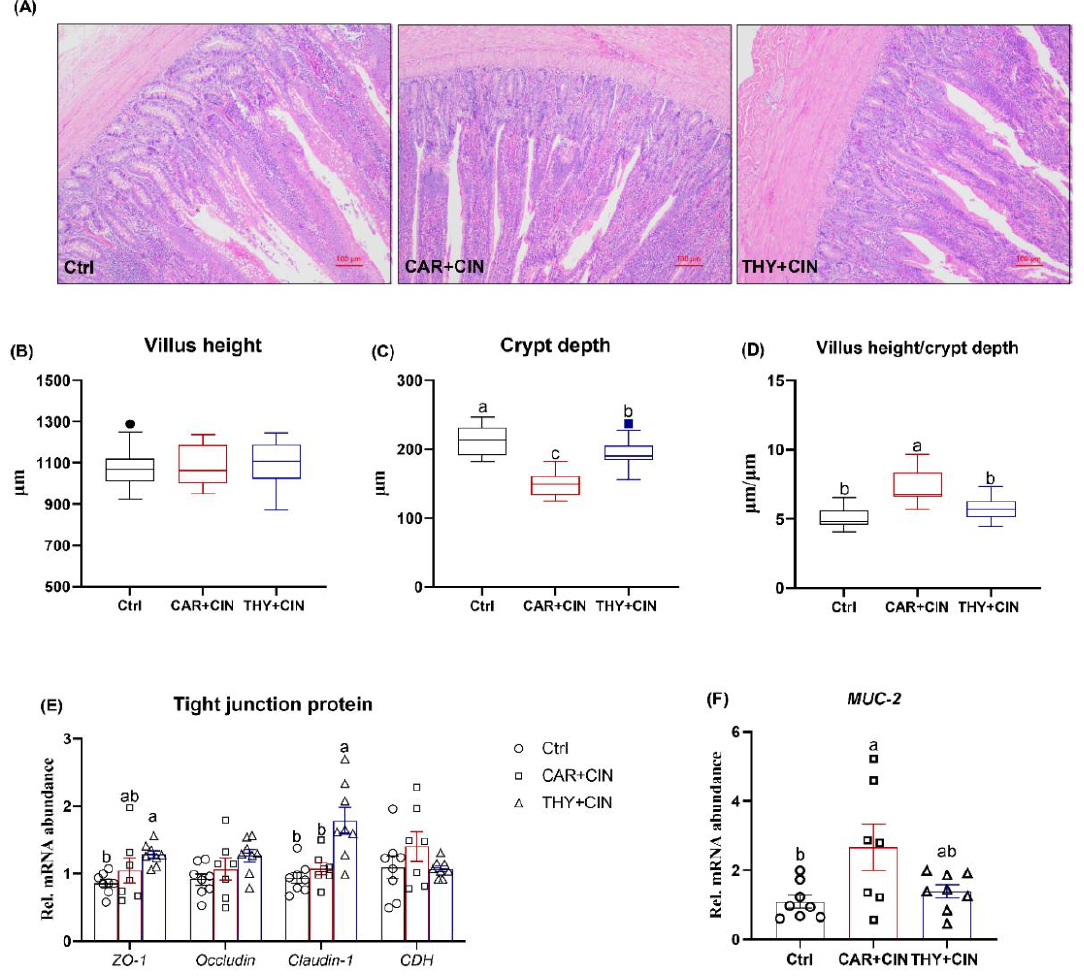
Figure 3. Impacts of the combination of cinnamaldehyde with carvacrol (CAR+CIN) or thymol (THY+CIN) on morphology and intestinal barrier of mid-ileum in laying hens: ( A ) representative hematoxylin/eosin staining (scale bar = 100 μm), and ( B ) villus height, ( C ) crypt depth, and ( D ) the ratio of villus height to crypt depth were measured in ileum, ( E , F ) mRNA abundance of Zonula occludens-1 (ZO-1), Occudin, Claudin-1, Cadherin 1 (CDH1), and MUC-2. Boxes are bounded by the 25th and 75th percentiles, with the median shown by the line bisecting the box. Whiskers extend to the full range of the data. Outliers are represented by dots. In the scatter plot, values are mean ± standard error (SE) represented by vertical bars. a,b Values without common superscript are notably different ( p < 0.05, n = 8).